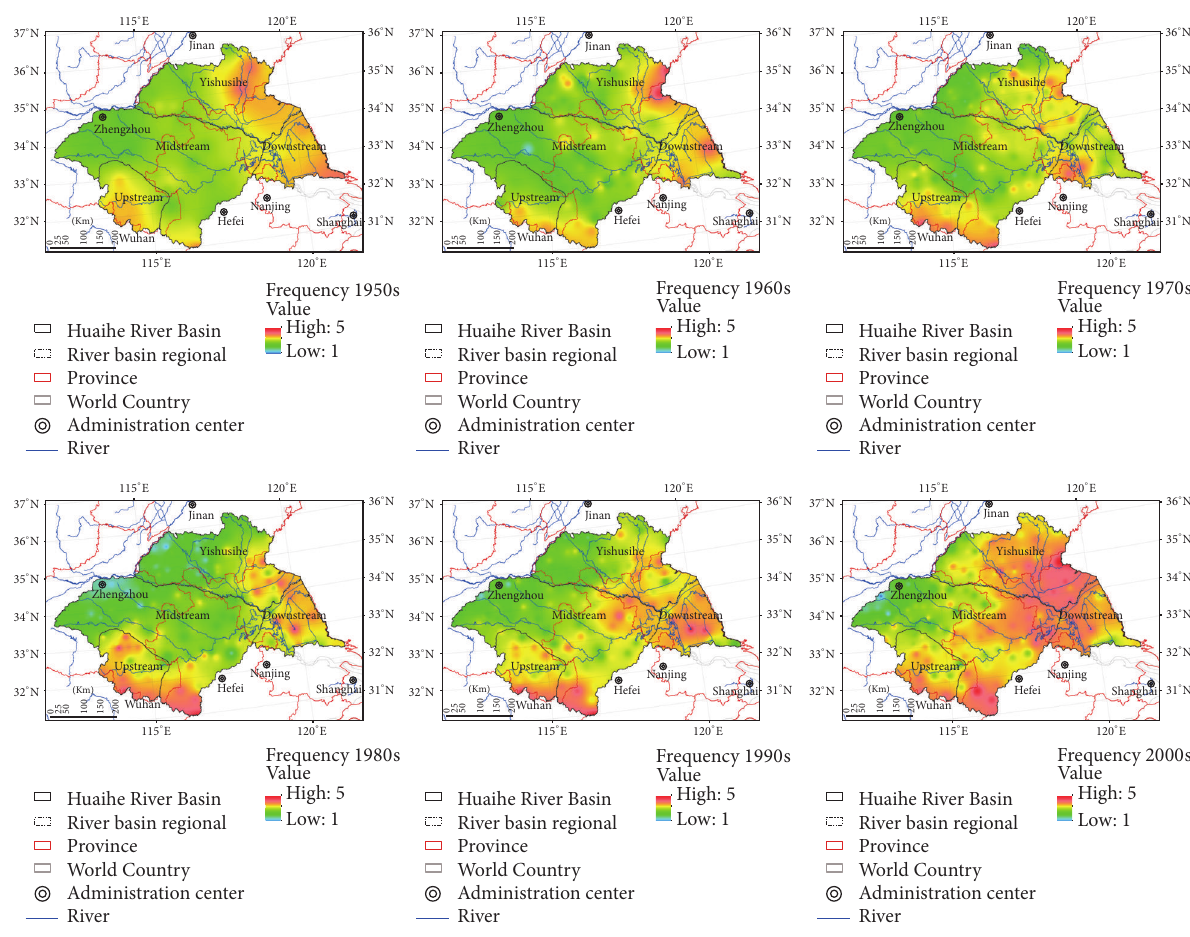
Figure 9: Spatial distribution of isolated rainstorm event frequency during